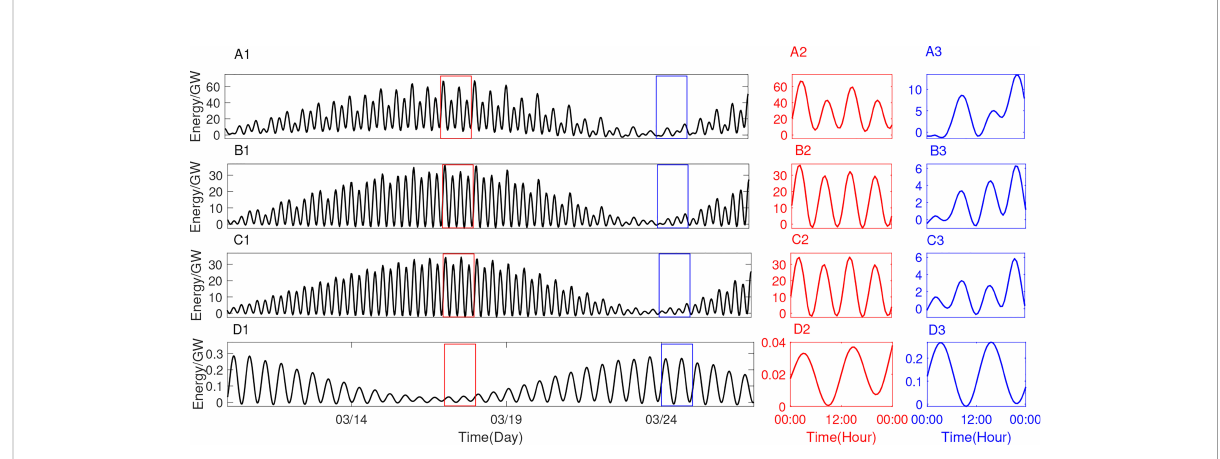
FIGURE 16 Time series of the barotropic-to-baroclinic energy conversion rate in the Andaman Sea, in which (A1 ∼ A3) is in the whole Andaman Sea in Experiment 1, (B1 ∼ B3) is in subdomain C in Experiment 1 , (C1 ∼ C3) is in subdomain C in Experiment 2, and (D1 ∼ D3) is in subdomain C in Experiment 3. A2 (A3) , B2 (B3) , C2 (C3) , and D2 (D3) are on March 17 (24), corresponding to the red (blue) rectangle in A1 , B1 , C1 , and D1